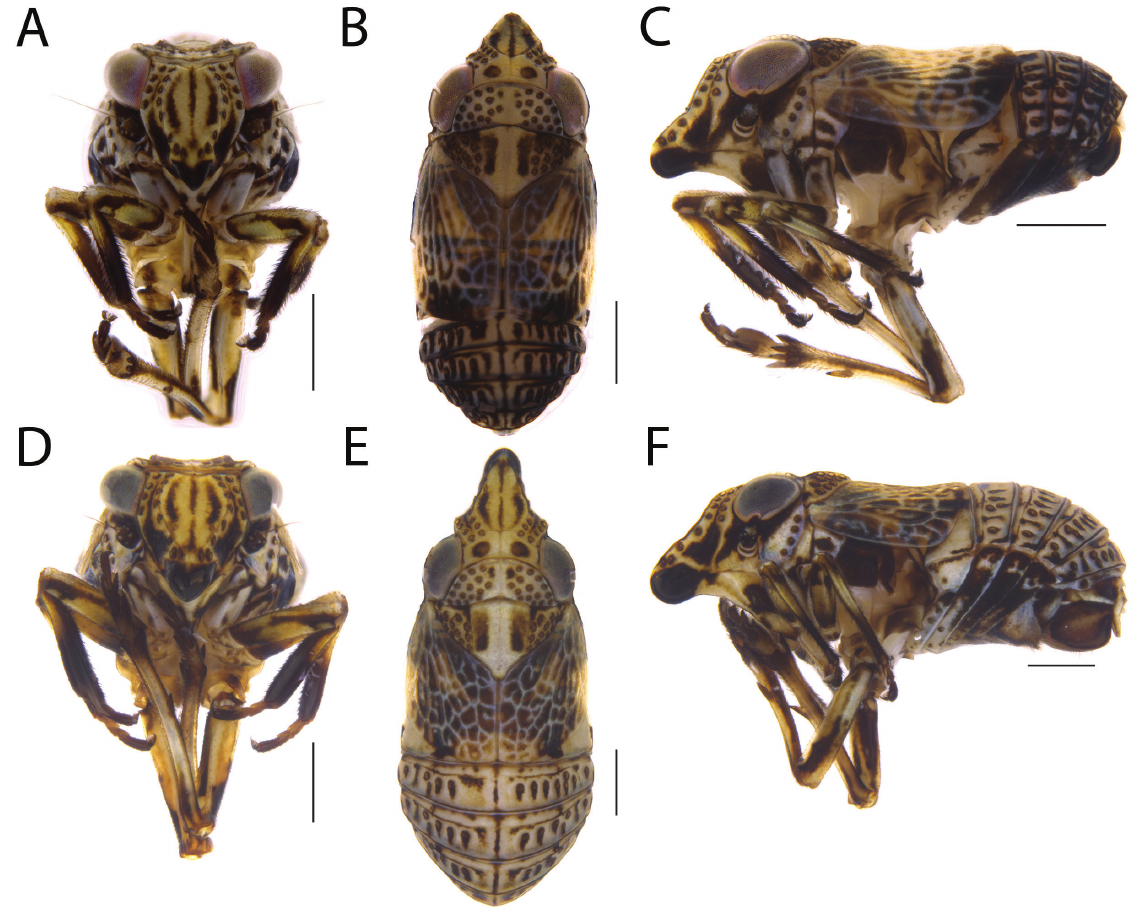
Fig. 13. Habitus of Fitchiella zahniseri sp. nov. A–C . Holotype, ♂ (NMNH). A . Frontal view. B . Dorsal view. C . Lateral view. D–F . Paratype, ♀ (INHS). D . Frontal view. E . Dorsal view. F . Lateral view. Scale bars = 0.5